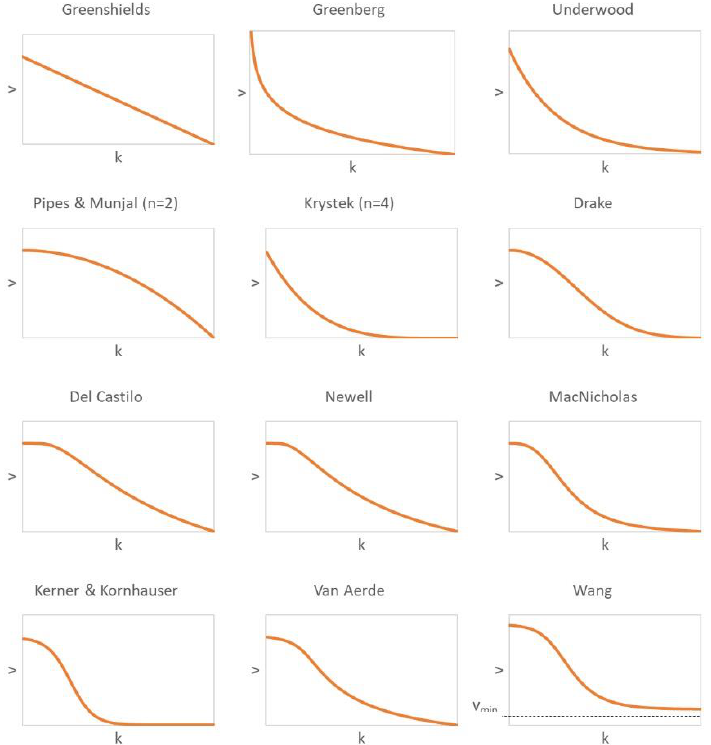
Figure 1. Representation of the speed–density relationship in selected traffic flow models.